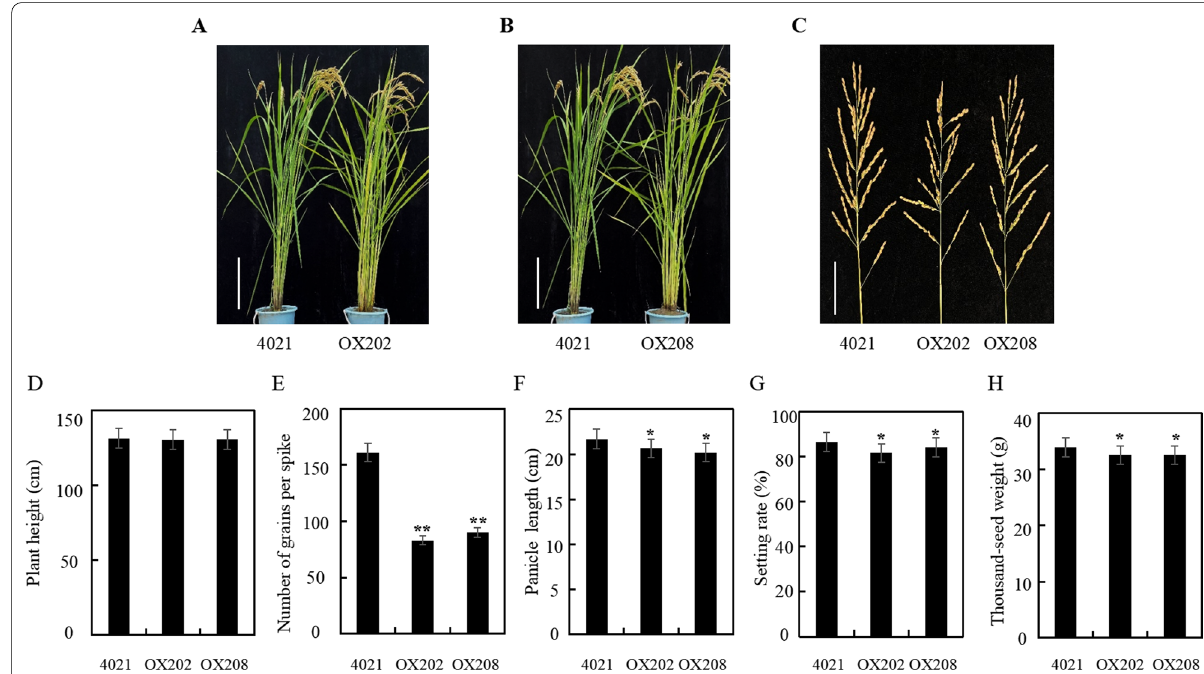
Fig. 5 Agronomic characters of MPK17-OX transgenic plants. A , B 4021 and MPK17-OX transgenic lines at mature stage (Bar 30 cm). C Panicles = of 4021 and MPK17-OX transgenic lines at mature stage (Bar 5 cm). D Columns showing plant height. E Columns showing numbers of grains per = spike. F Columns showing for panicle length. G Columns showing for seed setting rate. H Columns showing 1000-grain weight. OX202 and OX208: independent MPK17-OX transgenic lines; CK: 4021 (TP309 transgenic line harboring the Xa21 gene). Mean was calculated for eight individual plants. Error bars are standard deviation (SD). “*” and “**” designate difference at p < 0.05 and p < 0.01 levels